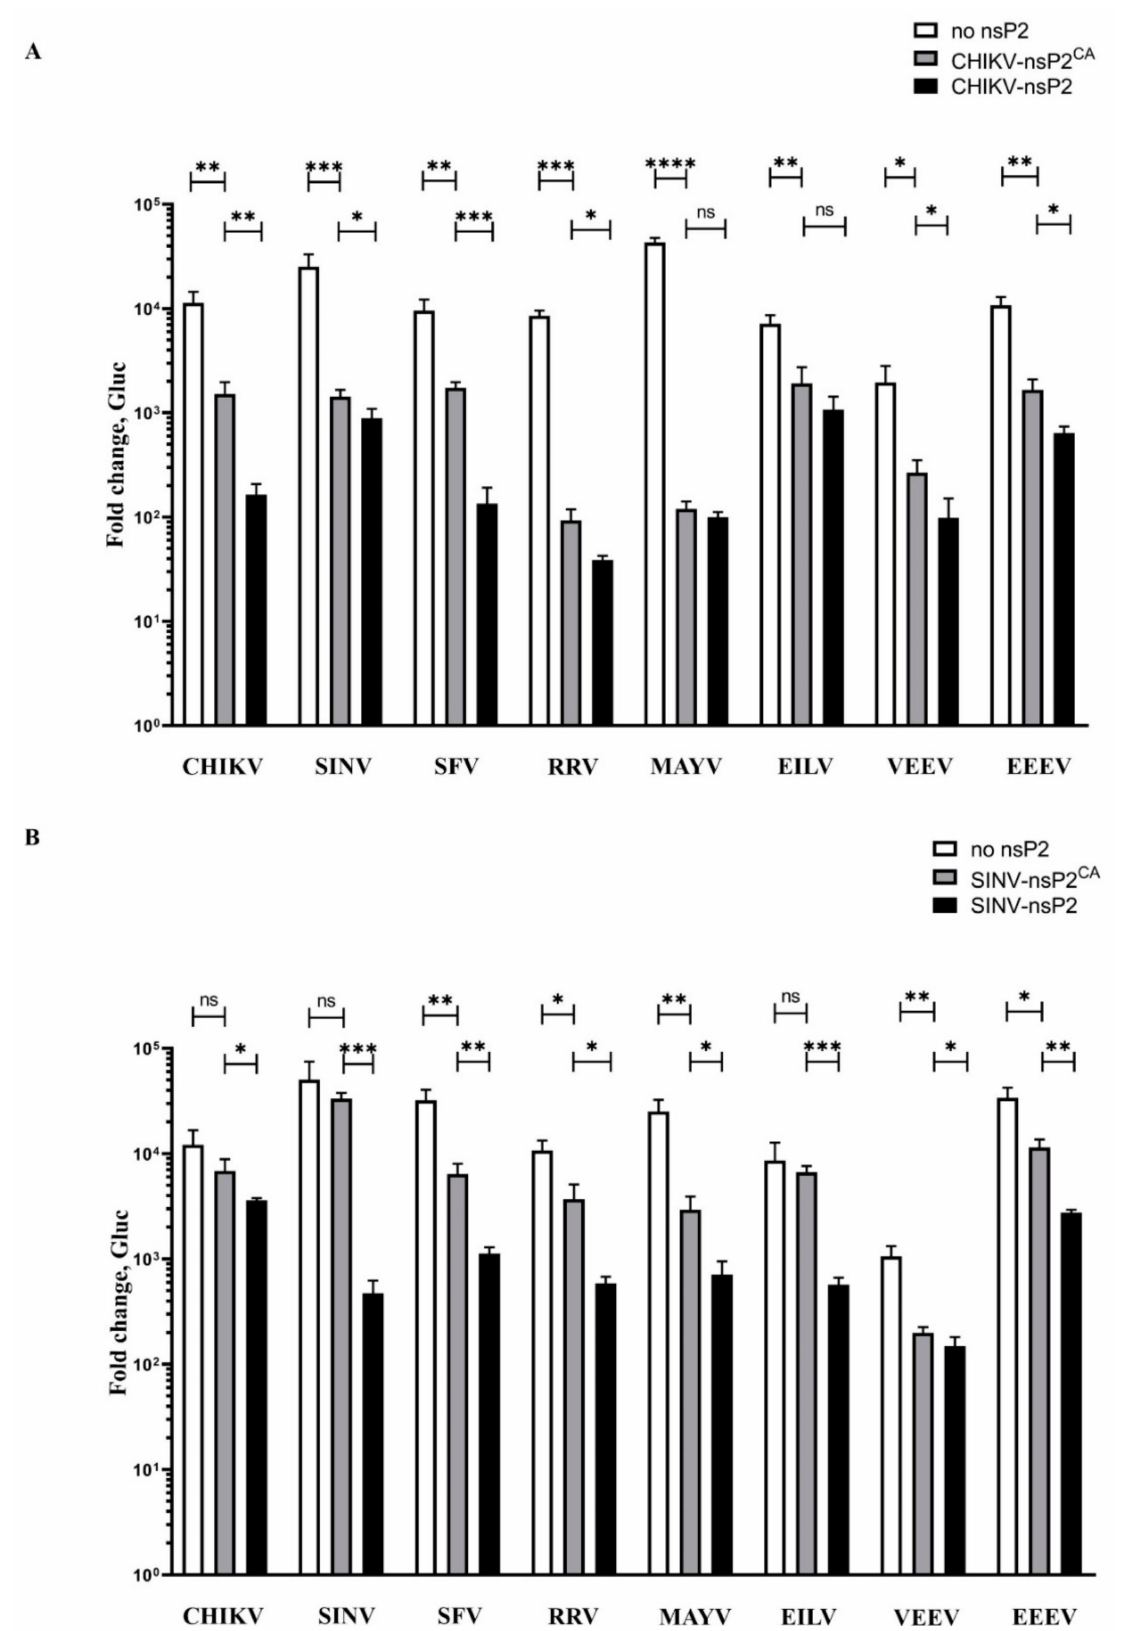
Figure 4. Co-expression of nsP2 of CHIKV or SINV inhibits activity of trans-replicases of heterologous alphaviruses. ( A